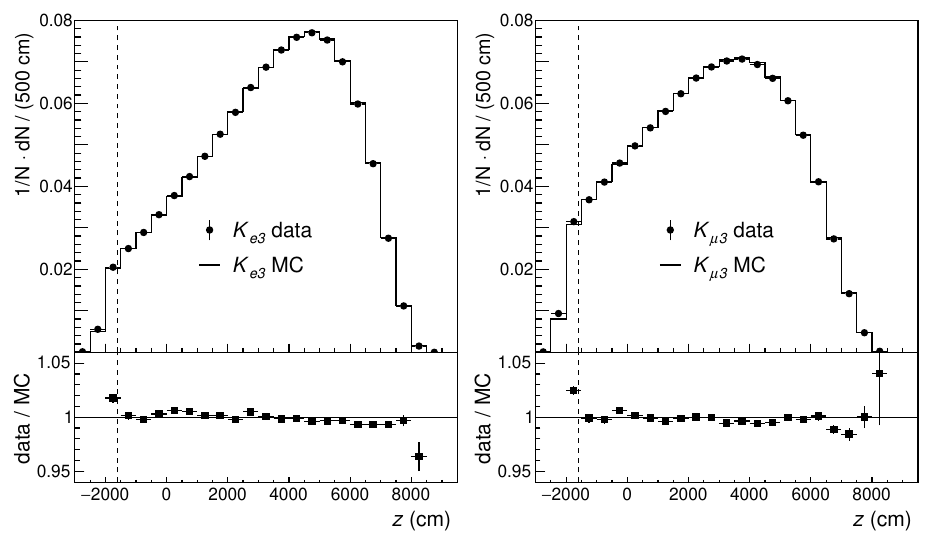
Figure 1 . Distributions of the decay vertex z position for data and MC simulated samples for K (cid:6) (left) and K (cid:6) (right) modes and corresponding Data/MC ratios. The simulated samples include (cid:22) 3 signal and backgrounds. The vertical dashed lines indicate the cut applied (the (cid:12)nal collimator exit is located at (cid:0) 1800